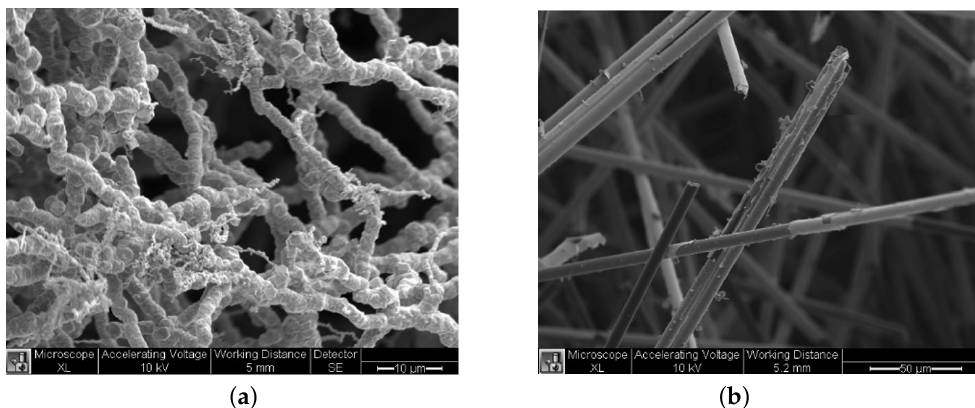
Figure 1. SEM images of the two electrically conductive filler materials. ( a ) SEM of NiNs. ( b ) SEM of NCCFs.